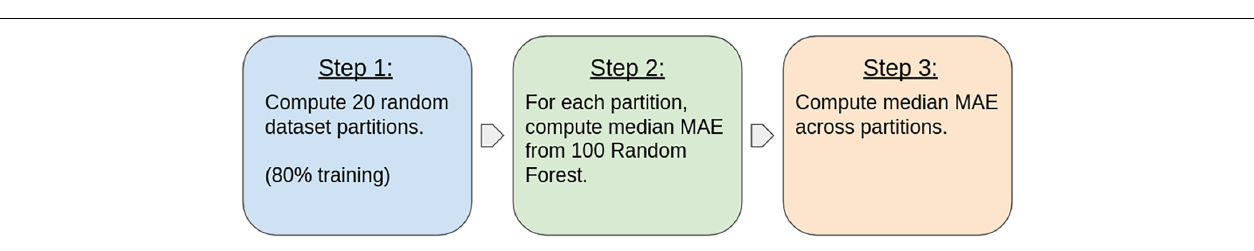
FIGURE 3 | Method pipeline used for computing the resulting errors for each area and for each mathematical